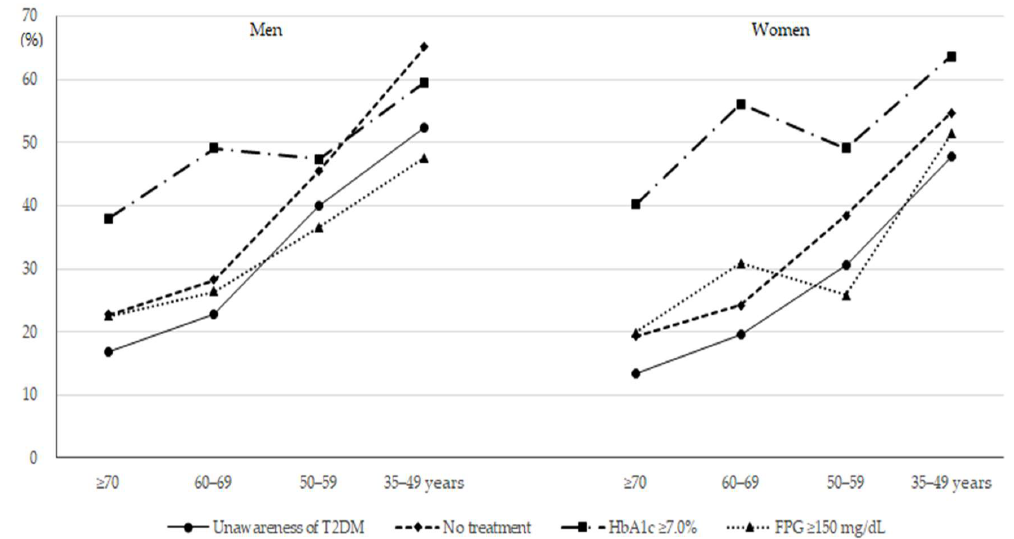
Figure 1. Proportions of unawareness, non-treatment, and poor glycemic control of T2DM according to age groups (all p for trend < 0.05). Table 3. ORs (95% CIs) of unawareness, non-treatment, and poor glycemic control of T2DM according to age groups.